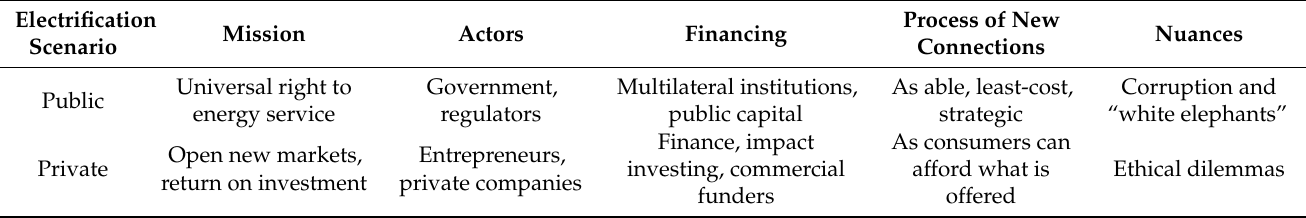
Table 1. Characteristics of principal electrification